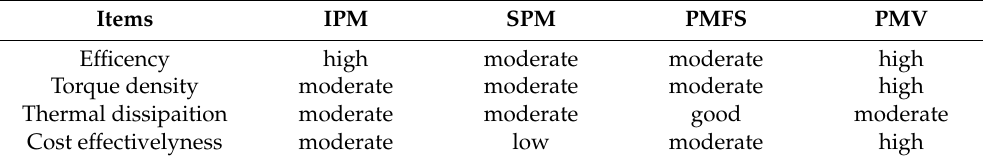
Table 5. Evaluation of Proposed